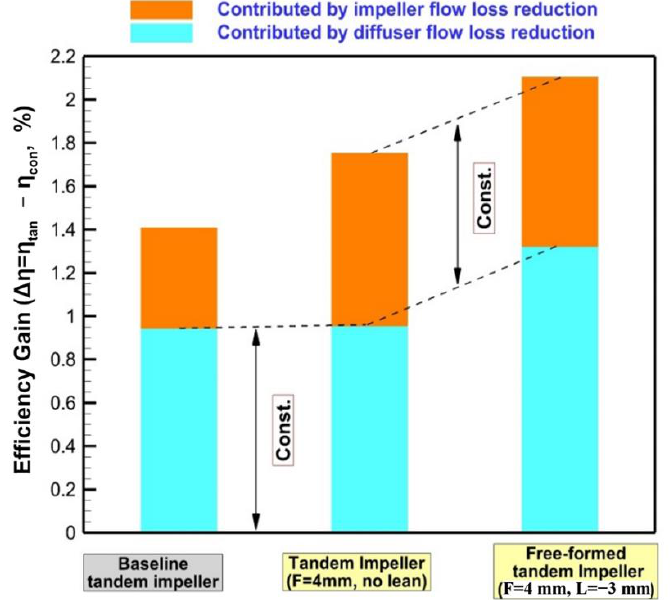
Figure 22. The contribution of the stage efficiency gain with different tandem impeller designs (P.E.